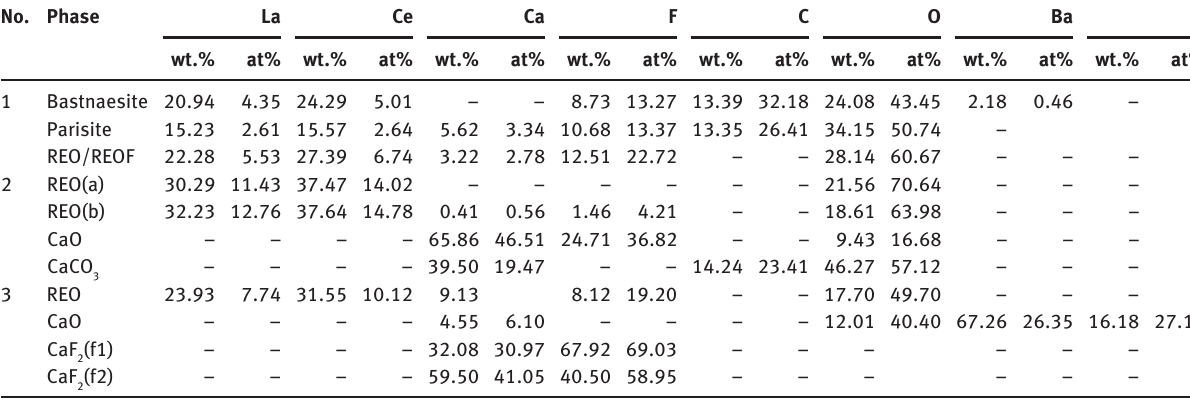
Table 6: EDS analysis.